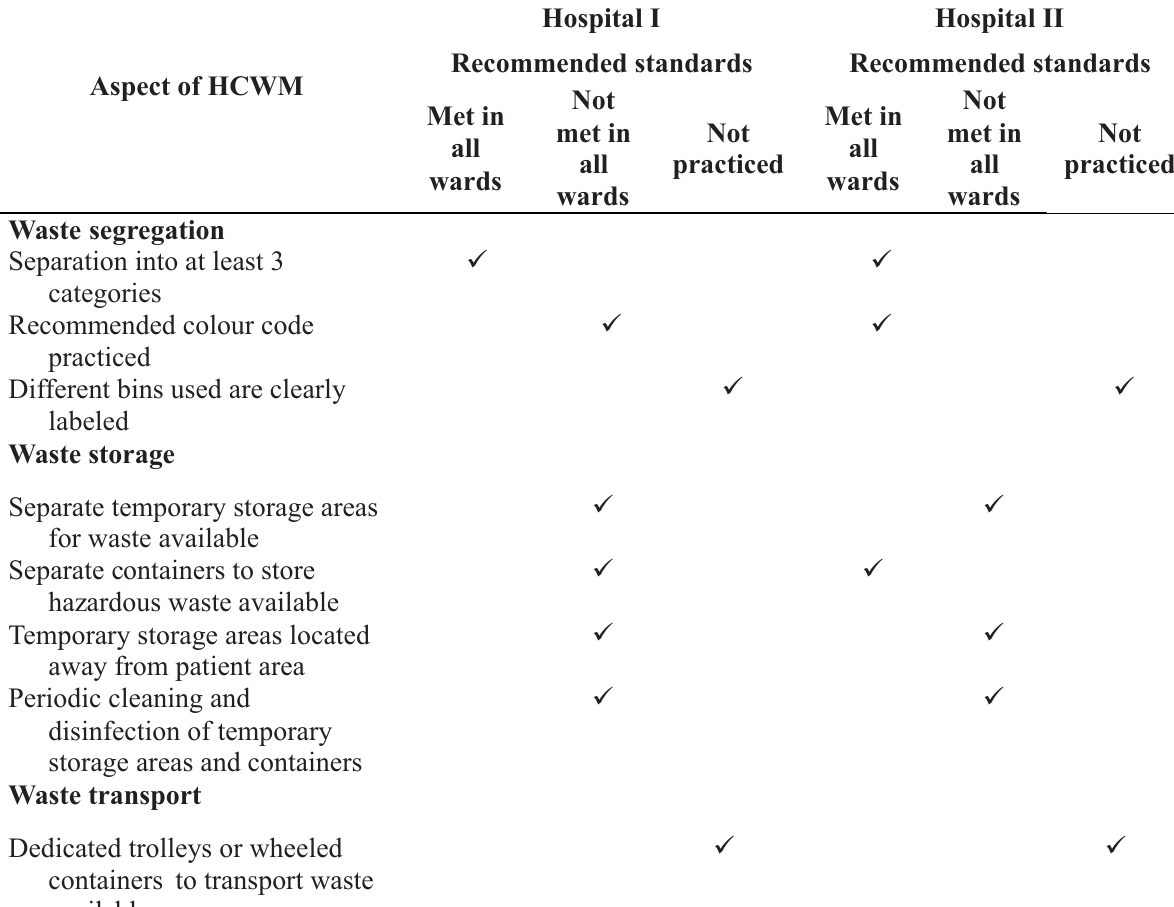
Table 3: information related to processes of HCWM in two hospitals